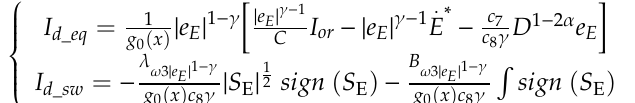
( b ) Figure 5. ( a ) Reference speed tracking comparison under normal conditions; ( b ) speed error comparison